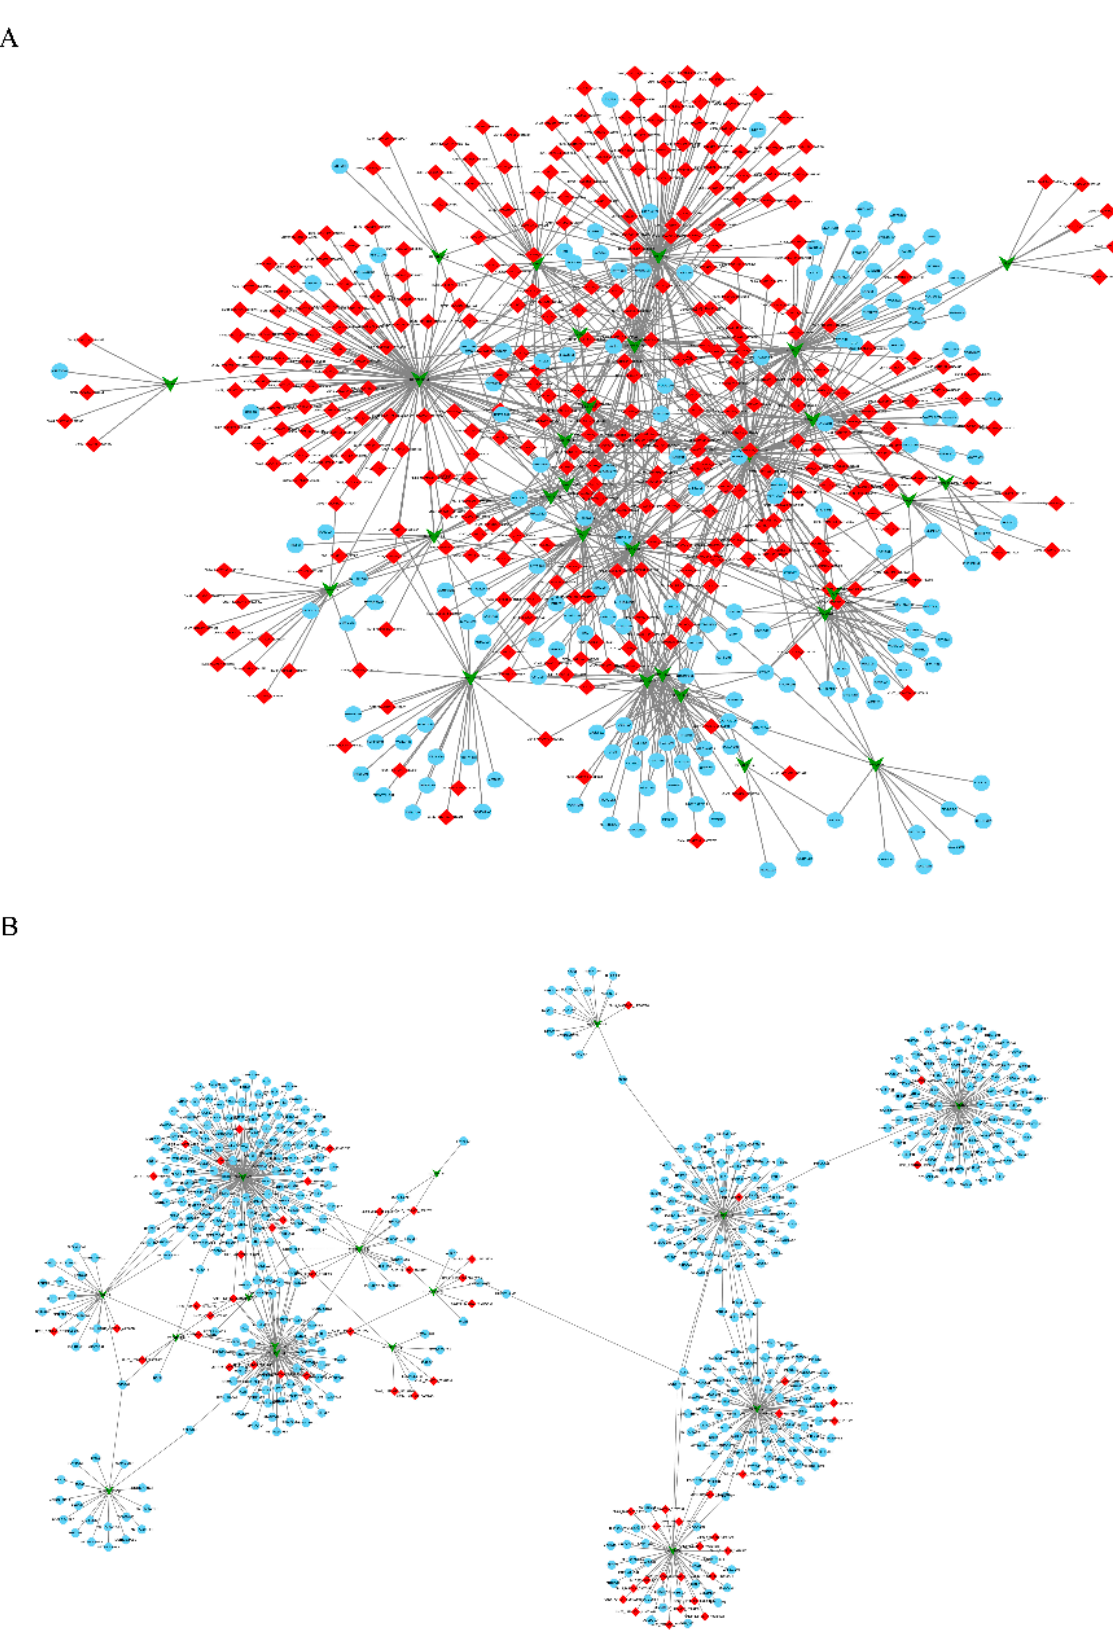
Figure 6. A view of interaction among circRNAs–miRNAs–mRNAs in skeletal muscle ( A ) and subcutaneous fat ( B ). Red diamond nodes represent circRNAs; blue circle nodes represent mRNAs; and green arrow nodes represent miRNAs.